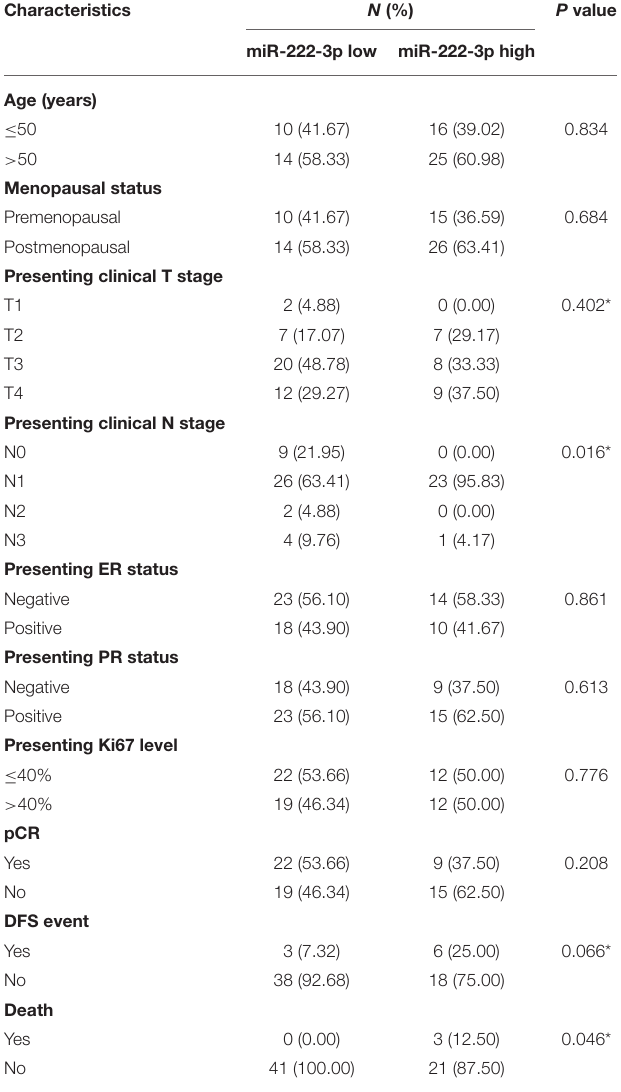
TABLE 1 | The association of serum miR-222-3p with clinicopathological characteristics. Characteristics